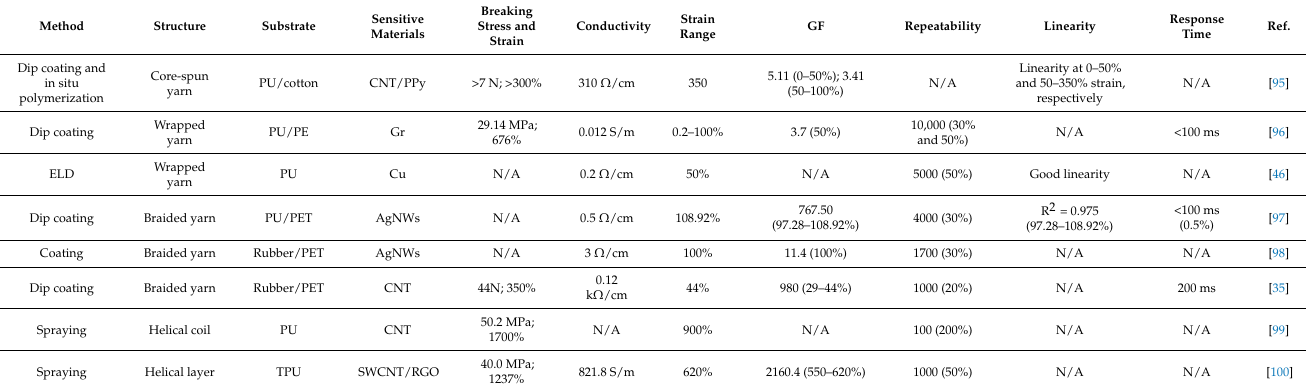
Table 6. Characteristics of various yarn-based strain